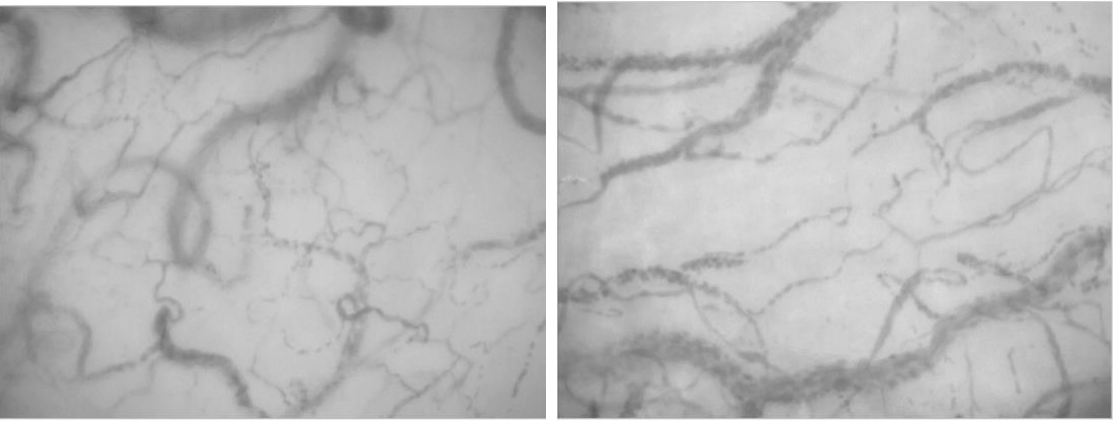
Figure 2. Sublingual microcirculation images from patients with sepsis, displaying characteristic heterogeneity of recruited vessels and reduced capillary density.